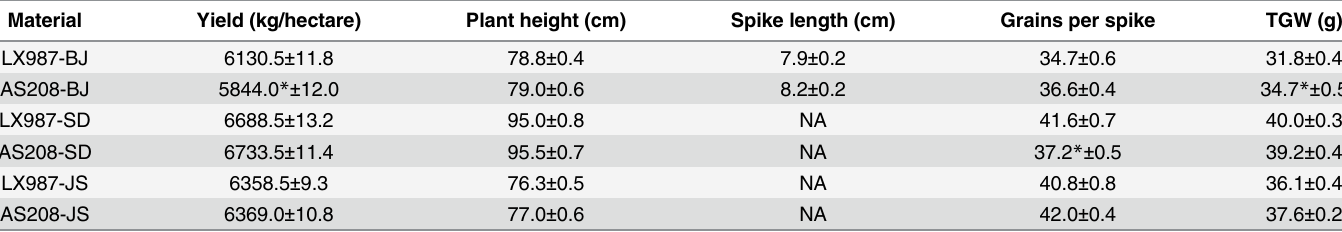
Note: Comparison between LX987 and AS208, signi fi cance at P < 0.05 represented by * . BJ, SD, and JS stand for the plants grown in Beijing, Shandong, and Jiangsu, respectively, which is the same in the following